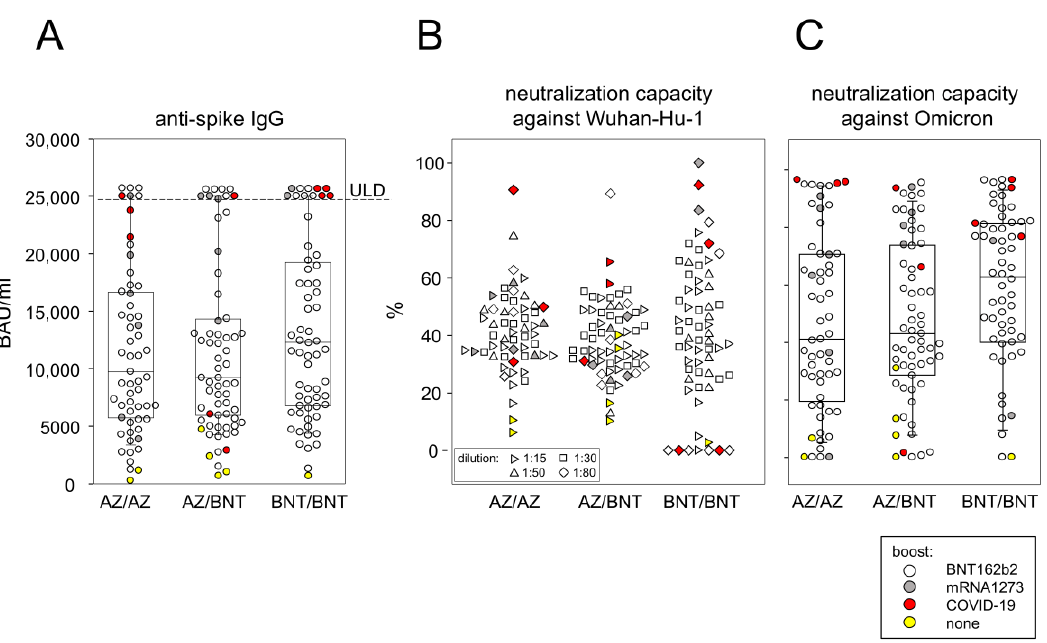
Figure 3. ( A ) Dot plots and corresponding box plots show anti-spike IgG concentrations (BAU/mL) in relationship to the respective vaccination regimen. The p value resulting from Kruskal–Wallis with post hoc test was 0.2865, indicating comparable IgG concentrations between vaccination groups. ( B ) Neutralization capacities against the Wu-Hu-1 spike protein. Serum dilutions, required to obtain neutralization capacities between 0 and 100%, are indicated by different symbols. ( C ) neutralization capacities of undiluted sera against the Omicron variant are presented in %. The p value resulting from Kruskal–Wallis with post hoc test was 0.0645, indicating comparable neutralization capacities between vaccination groups. Color codes indicate boost variants. AZ/AZ: homologous primary/secondary immunization with AZD1222, AZ/BNT: heterologous primary/secondary immunization with AZD1222 and BNT162b2, BNT/BNT: homologous primary/secondary immunization with BNT162b2. ULD: upper limit of detection.